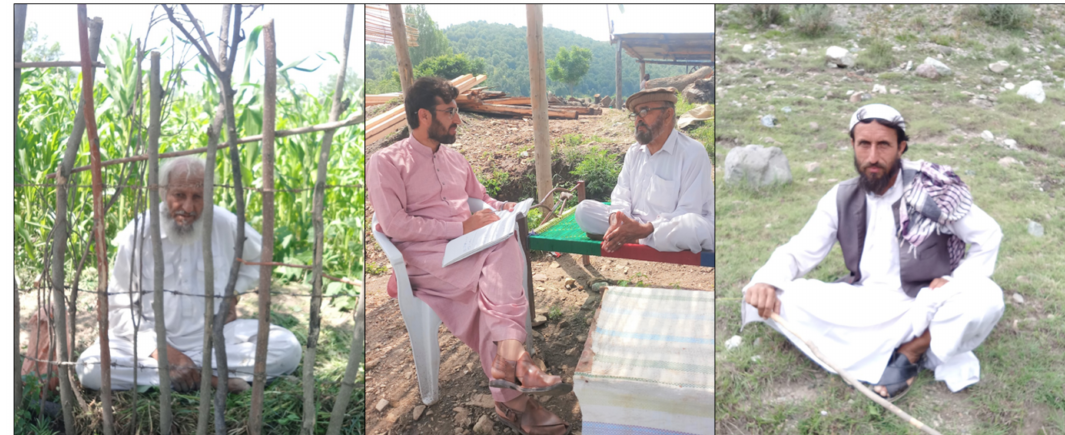
Figure 3. Local participants interviewed during the